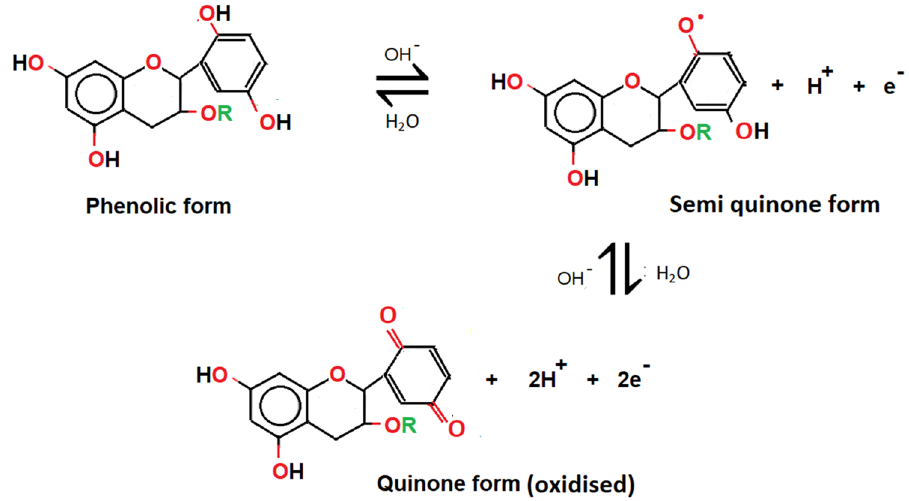
Figure 6. Schematic illustration of the chemical structures of TA’s phenolic, semi-quinone and quinone